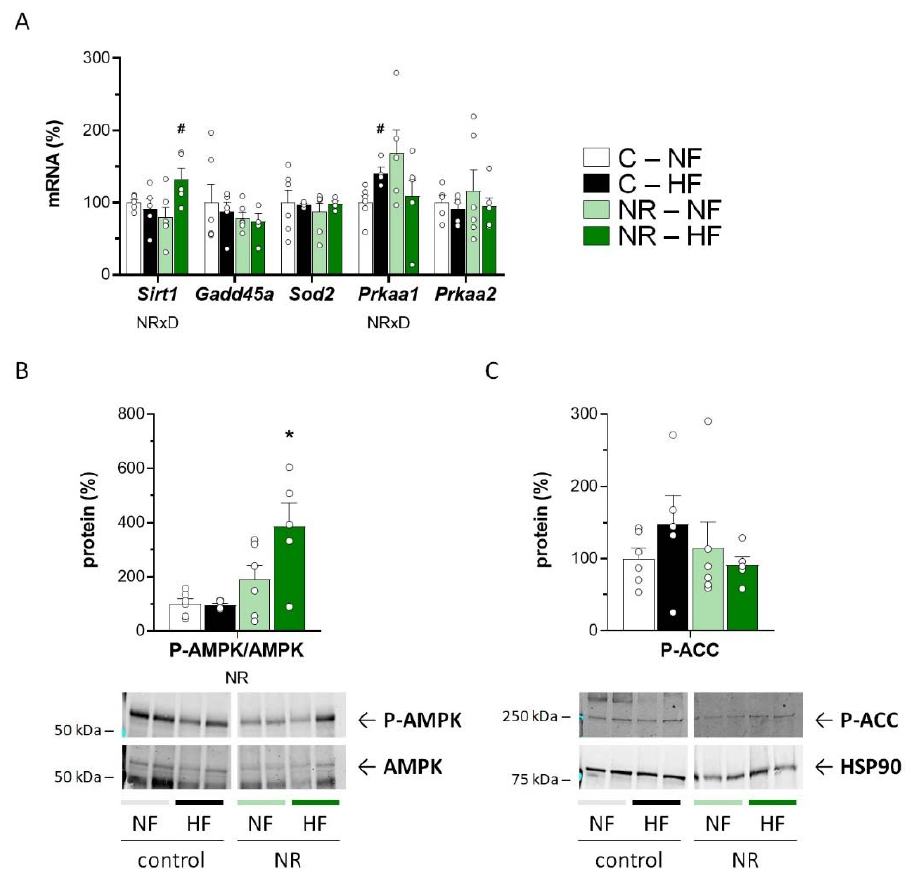
Figure 3. Early-life nicotinamide riboside (NR) treatment up-regulated AMPK and SIRT1 in skeletal muscle in adulthood. Newborn male mice received NR or vehicle (water; control) from day 2 to 20 of age, were weaned onto a chow diet on day 21, and were assigned to either an HF or a normal-fat (NF) diet on day 90 for 10 weeks. mRNA levels of the indicated genes related to SIRT1 and AMPK pathways ( A ), phospho-AMPK to AMPK ratio ( B ), and phospho-ACC protein levels ( C ) were analyzed in Gastrocnemius skeletal muscle at the end of the experiment. Data in the histograms are the mean ± SEM of 5–6 animals per group and are expressed relative to the mean value of the NF-control group, which was set to 100. Circles correspond to individual data. Illustrative Western blots are shown at the bottom of panels B and C (see also Supplementary Figure S3). Statistics ( p < 0.05): NR treatment, and NRxD treatment per diet interaction (Two-way ANOVA); * NR vs. control, # HF vs. NF ( t -Student).